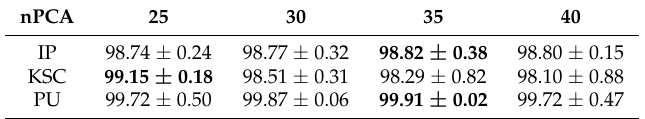
Table 3. Overall Accuracy based on PCA number. The number in bold is the best Overall